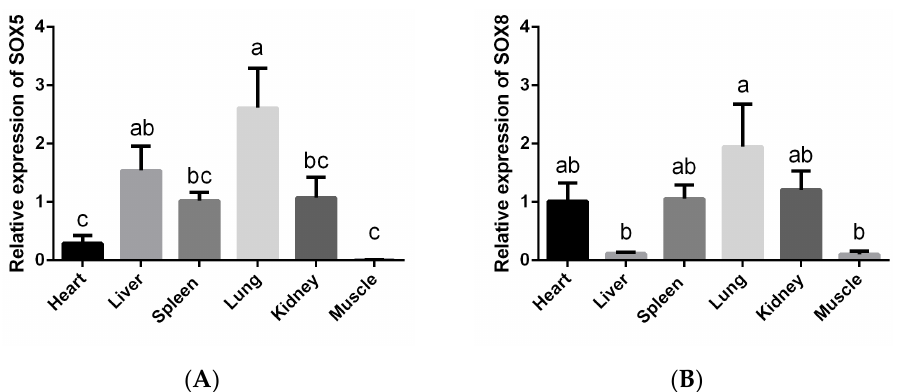
Figure 2. Gene expression of SOX5 and SOX8 in different tissues. ( A ) SOX5 expression in different tissues, and ( B ) SOX8 expression in different tissues. a, b, and c denote significant at p < 0.05.